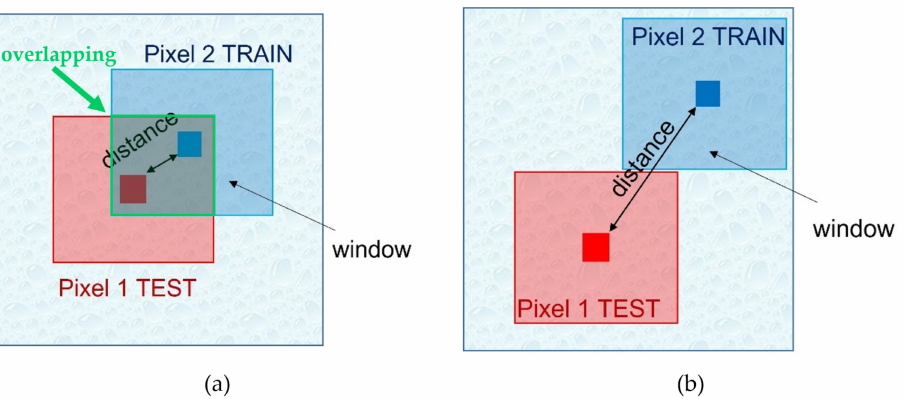
Figure 7. A representation of the overlapping phenomenon between two pixels when a spatial operation is performed, based on a window centered on a pixel: ( a ) random sampling, ( b ) proposed controlled sampling ensuring no